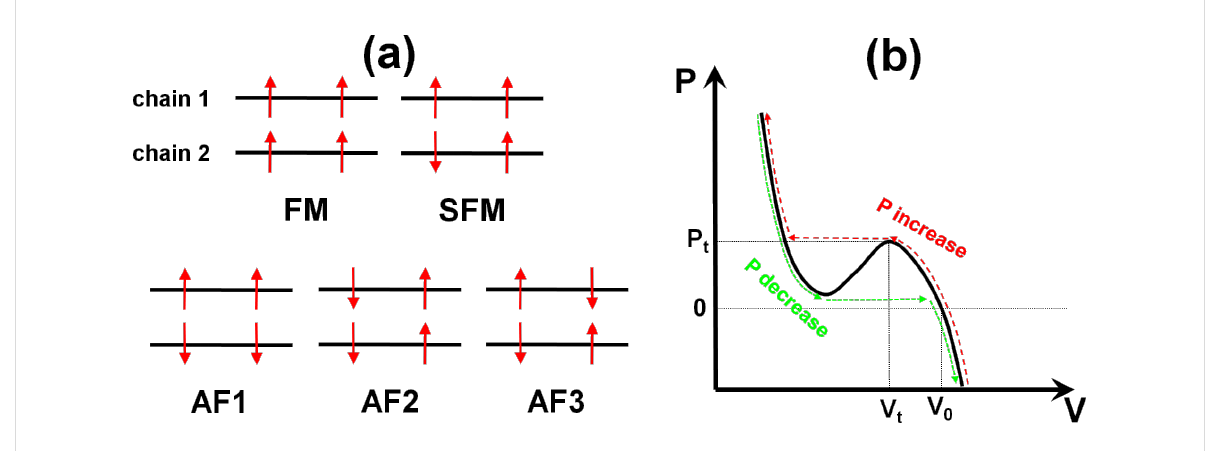
Figure 2: (a) Schematic representation of the five inequivalent magnetic configurations investigated in this work: ferromagnetic (FM), semi-ferromag- netic (SFM) with one ferromagnetic and one antiferromagnetic chain, and three different antiferromagnetic (AF) configurations. (b) Schematic repre- sentation of the P(V) relation of the MIL-47(V) MOF. The extrema of the s-shaped curve represent the points at which a pressure-induced phase tran- sition occurs. The red dashed and green dotted curves indicate the path followed for increasing and decreasing pressure,